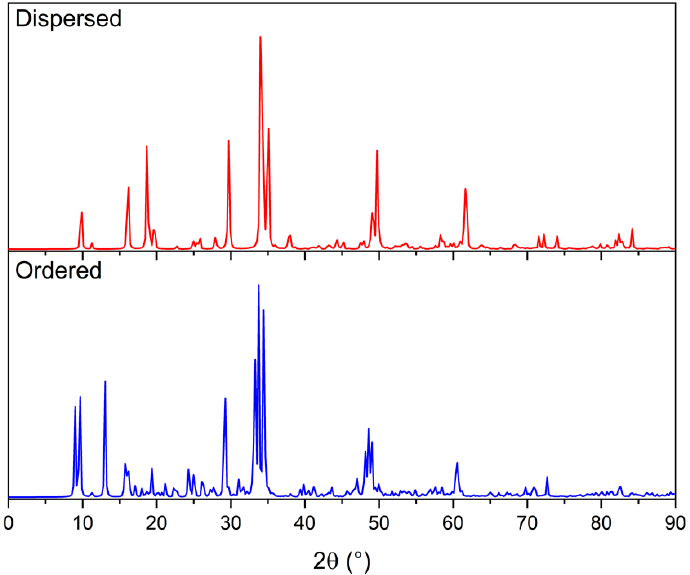
Figure 7. Calculated XRD pattern for dispersed (red) and ordered (blue) structure.